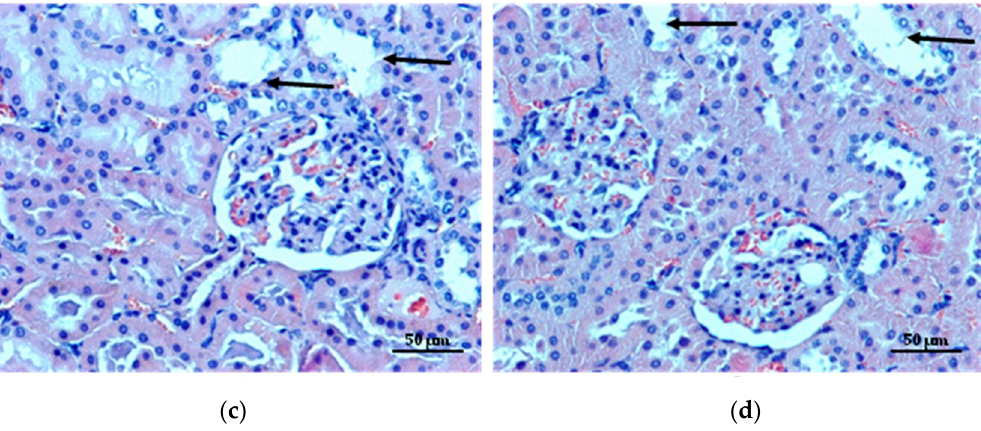
Figure 9 Figure 9. Representative hematoxylin and eosin stained paraffin kidney section of diabetic rats ( a ) shows severe cellular injury: swelling (arrows), vacuolization and detachment of epithelial cells from the basement membrane (dashed arrows), strong congestion of glomeruli (arrowheads). Kidney of diabetic rats treated with MF ( b ) shows improvement in the renal histology, reduction in congestion in the parenchyma (arrows) and reduction in renal glomeruli (dashed arrows). Kidney sections of diabetic rats treated with non cross-linked microparticles formulation C ( c ) and cross-linked microparticles formulation CH1M ( d ) depict a significant improvement in the structure of the organ and reduction of lesions. Normal architecture, without congestion, with only slight changes in renal tubular epithelial cells is visible (arrows). Magnification ×